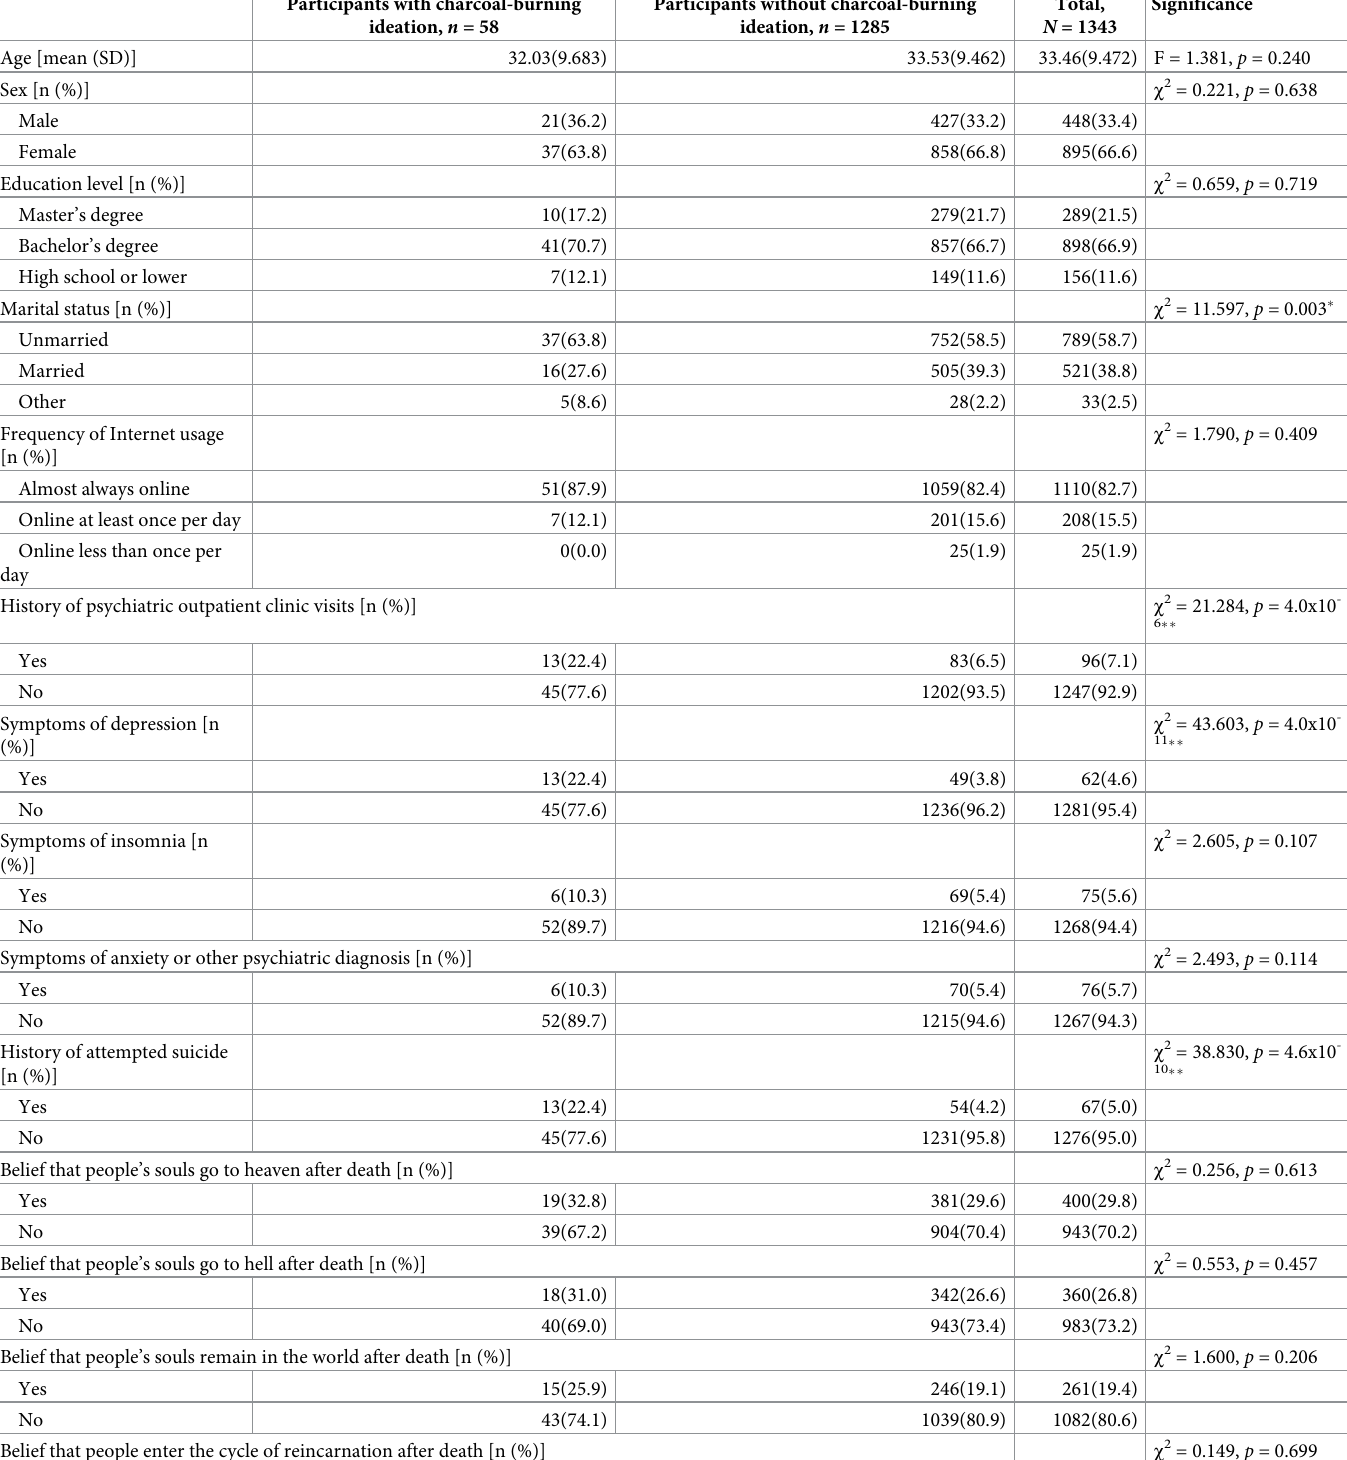
Table 2. Demographic data, psychiatric symptoms during lifetime, conceptualisation of life after death, and perceptions of charcoal-burning suicide in relation to presence of charcoal-burning suicide